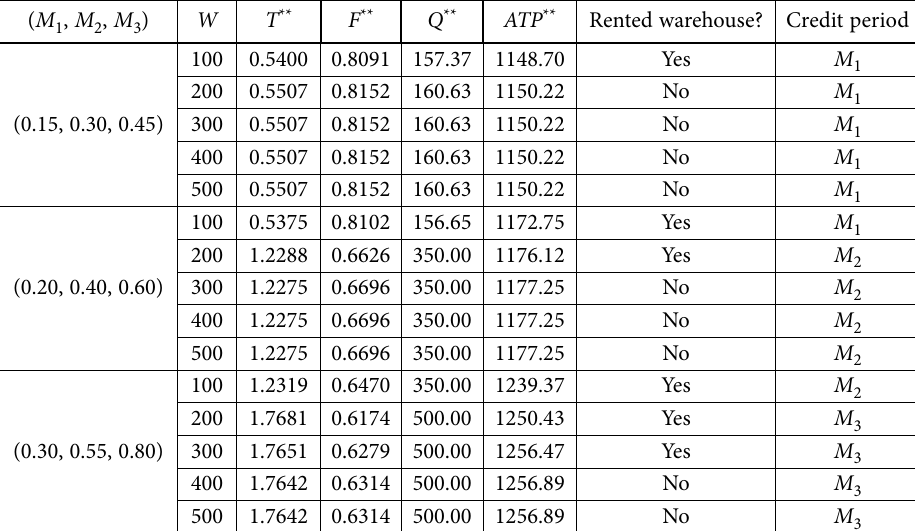
Table 4. Result of sensitivity analysis on W and ( M 1 , M 2 , M 3 ) ( M 1 , M 2 , M 3